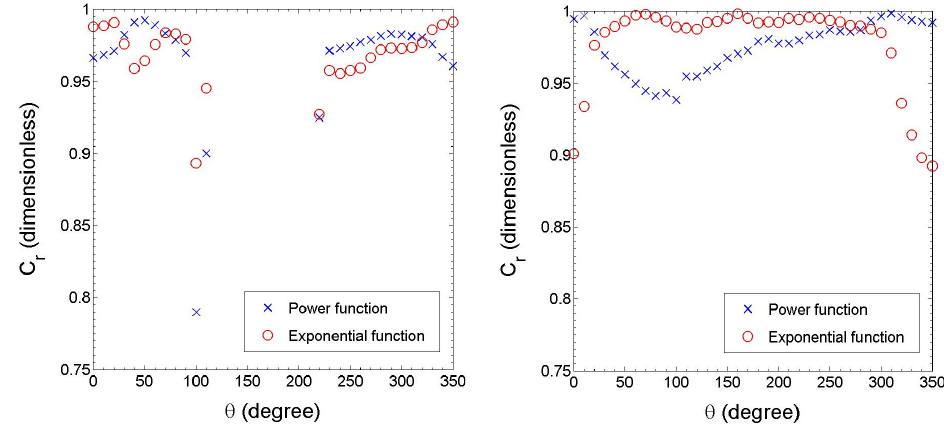
Fig. 6. Correlation C r as a function of θ (measured counterclockwise respect to the wind axis) for the fits in different directions for (a) the 21 December 1994 eruption of Popocat ´ epetl and (b) the 28 March 1982 eruption of El Chich ´ on. The “x” are the correlations to the power function, and the “o” to the exponential